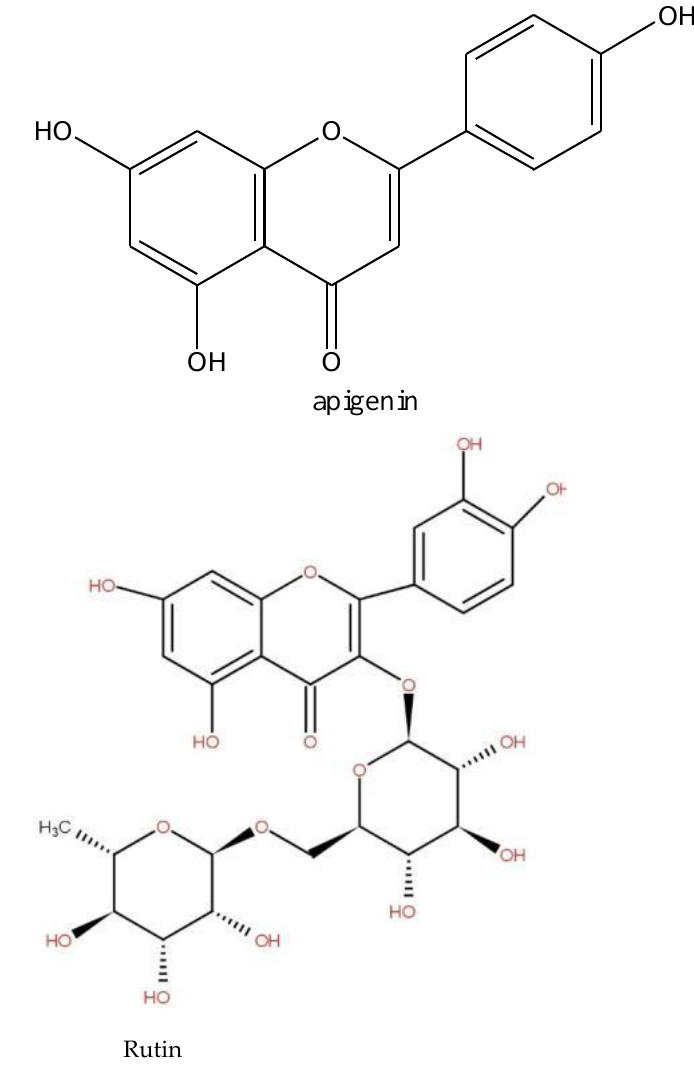
Figure 4. Structure of some stimulating, anxiolytic, sedative, and anticonvulsant properties isolate in medicinal plant. The second type was plants with adaptogen properties.